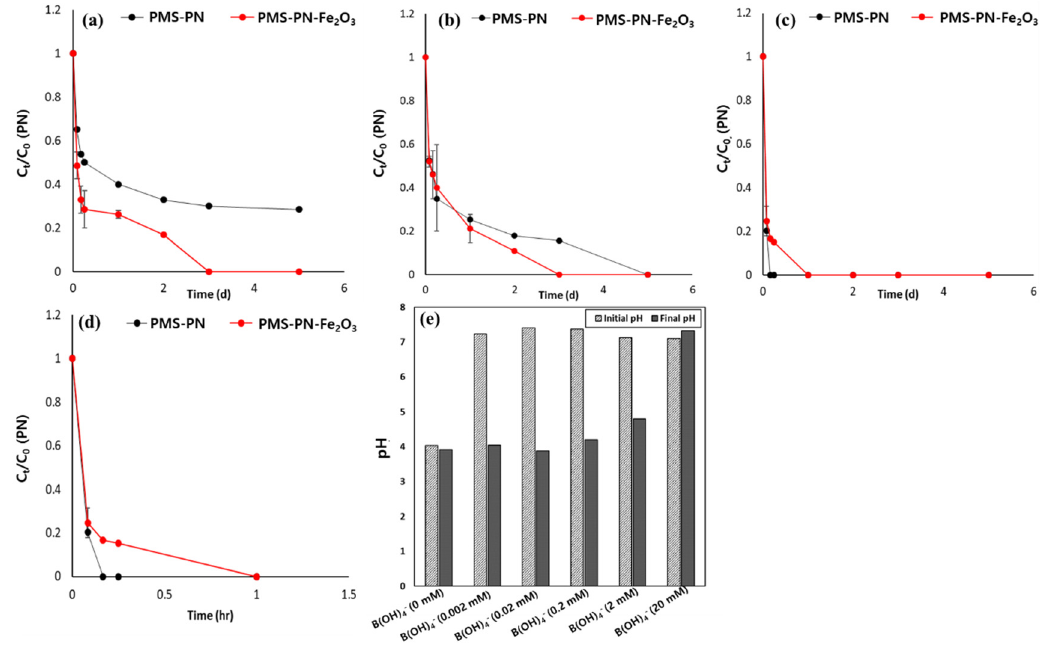
Figure 6. Comparison of PN degradation rates in the presence of Fe 2 O 3 and in the absence systems in various ranges of borate ion concentration ( a ) 2 mM of borate ions, ( b ) 5 mM, ( c ) 10 mM, and ( d ) 20 mM, and ( e ) the pH change during the reaction time ([PN] = 20 µM, [PMS] = 200 µM, [Fe 2 O 3 ] = 0.1 g/L, [pH] = 7.5~8.0).